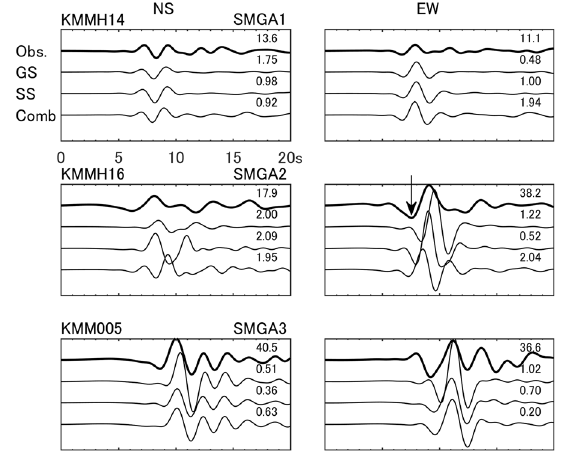
Fig. 7 Comparison of the observed (thick) and synthetic (thin) velocity waveforms at the target sites for the models in Table 3 and Fig. 6, with the period range of 1.5–10 s. GS grid search waveforms at Steps 1, 3 and 5; SS grid search waveforms at Steps 2, 4 and 6; Comb waveforms for the combined model at Step 7. Peak velocities are shown for the observed waveforms, whereas misfit WM are shown for the synthetic waveforms (the scales of amplitudes are common for all plots). Arrow indicates the westward pulse at